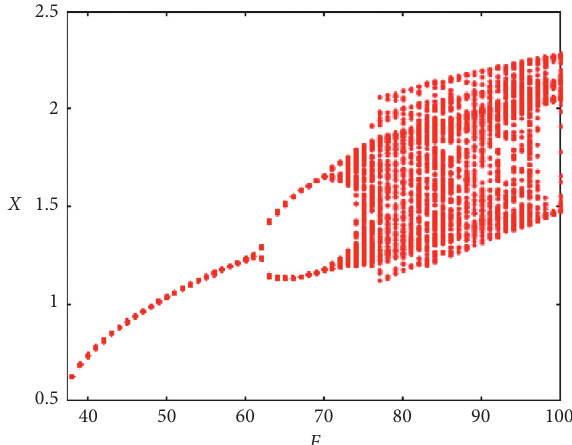
Figure 12: Local bifurcation diagram of the system at ω � 3.9